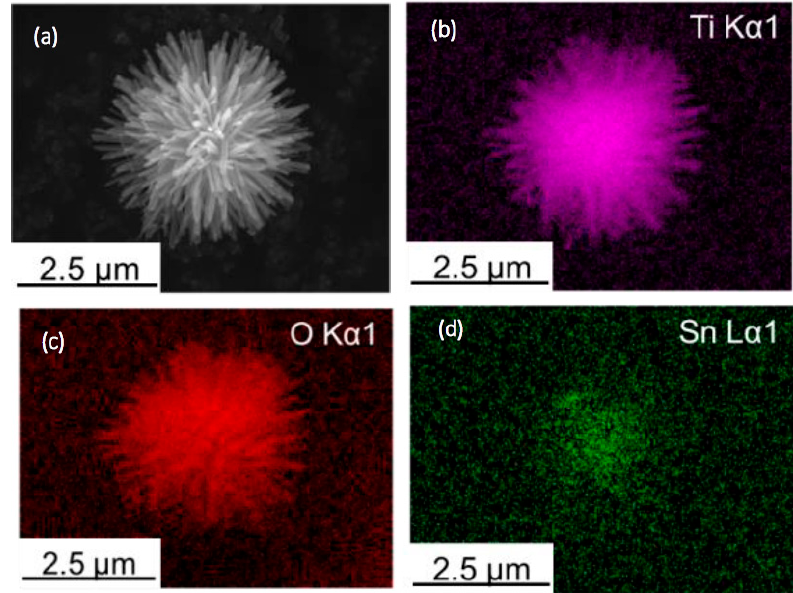
Figure 3. ( a ) STEM–EDS elemental mapping for a particle prepared by the hydrothermal reaction at t HT = 8 h (( b ), Ti; ( c ), O; ( d ), Sn). The figure is taken from Reference [14] (reproduced with permission from Akita, A.; Tada, H., Langmuir ; published by American Chemical Society, 2019).